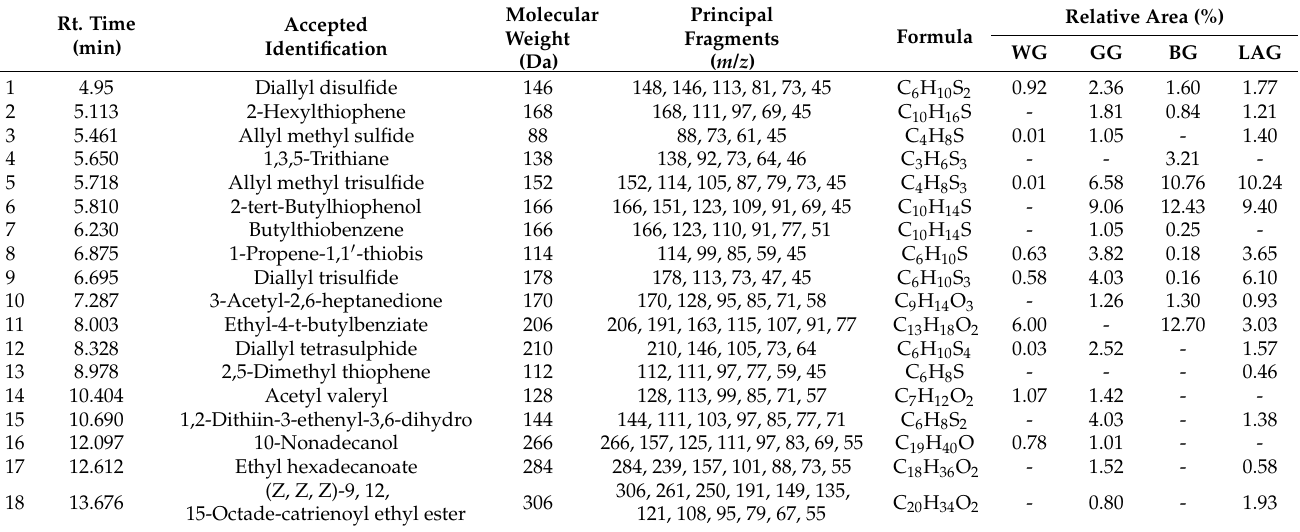
Table 2. GC-MS analysis of the constituents in the n-hexane extracts of WG, GG, BG and